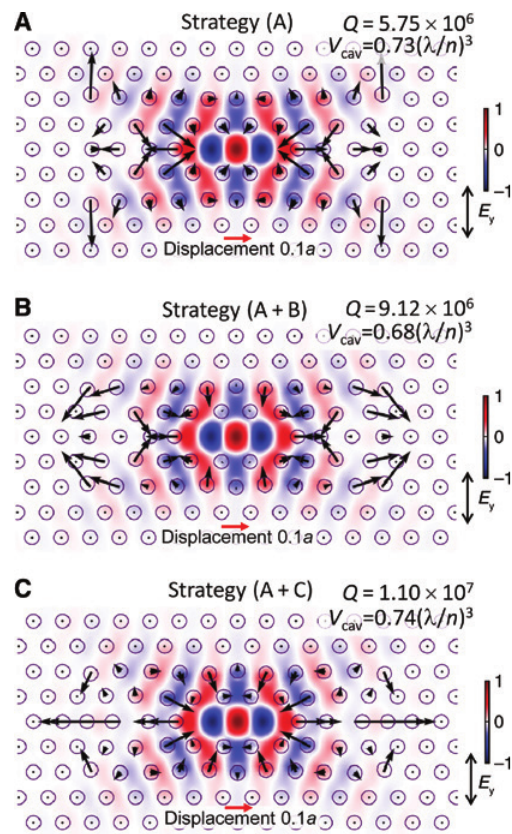
Figure 6: Air hole displacements of the optimized cavities. The results for three different strategies (A), (A + B), and (A + C) are shown in (A), (B), and (C), respectively. The circles represent the determined optimum positions of the air holes, and the arrows represent the displacement vectors with the scale shown by the red arrow. The electric field distributions of E are also plotted y in color. The highest Q factors of the structures generated by our proposed method during 101 iteration cycles are 5.75 × 10 6 , 9.12 × 10 6 , and 1.10 × 10 7 for strategies (A), (A + B), (A + C),